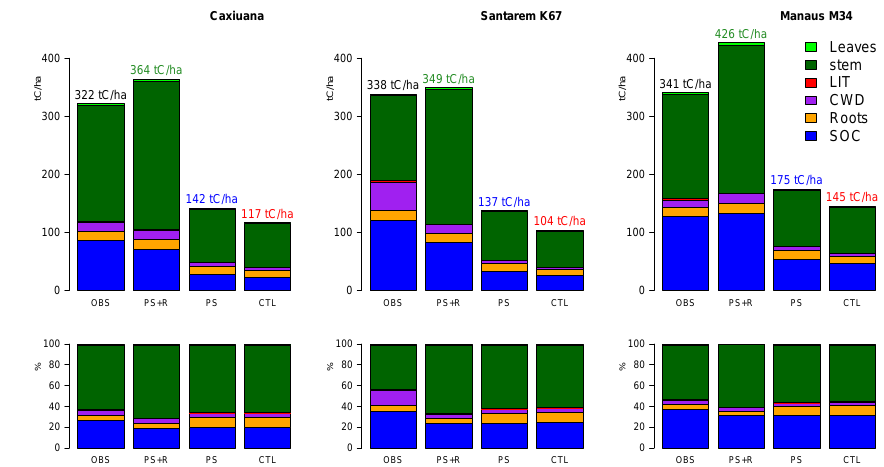
Figure 8. Observed (Mahli et al., 2009) and simulated (CTL, PS and PS + R) annual carbon pools (leaves (BL), stem ( B 2 + B 5 ), litter (LIT), coarse and woody debris (CWD), roots ( B 4 + B 6 ) and soil organic content (SOC)) at Caxiuanã, K67 and M34. Top panels show the absolute carbon stock in tCha − 1 and below panels the relative carbon stock (%).